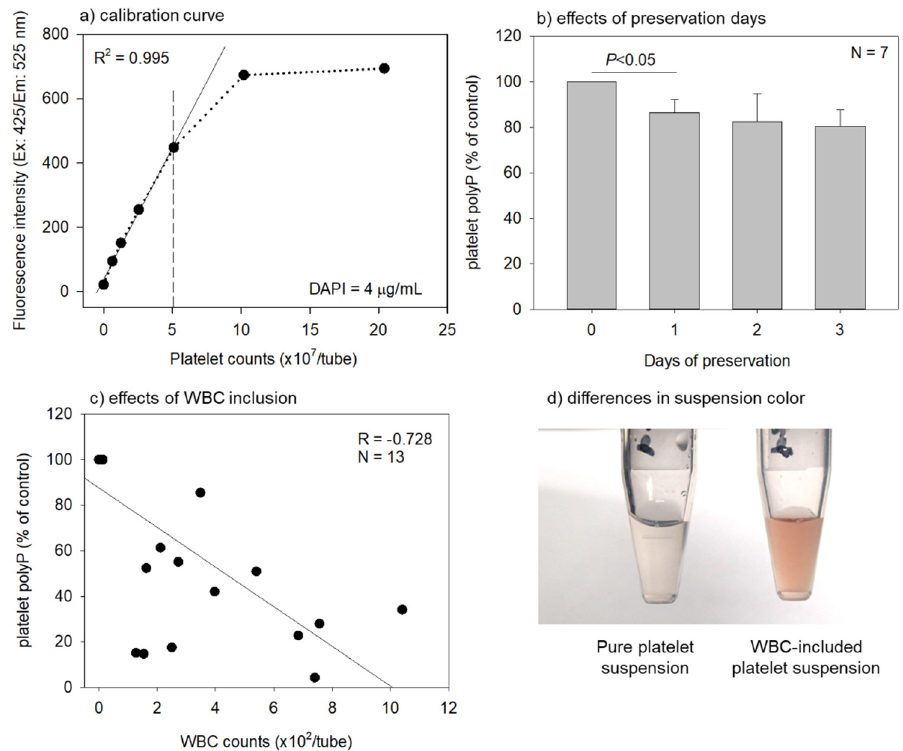
Figure 3. Standard curve for DAPI-reactive fluorescence intensity against platelets and the effects of various factors on polyP quantification. ( a ) A standard curve for the fluorescence signals in platelets probed with 4 μ g/mL DAPI. A good linear regression (R 2 = 0.995) was obtained in the range of platelet counts (up to 5 × 10 7 /tube). ( b ) The effects of preservation days on quantification of platelet polyP levels ( n = 7). A significant difference was observed only in the first 1-day interval. ( c ) Effects of WBC inclusion on quantification of platelet polyP levels. Since WBCs may shift the original polyP quantification upward, this downward shift may be due to RBC inclusion; a strong correlation (R = − 0.728) was observed; n = 13. ( d ) The representative difference in suspension color. The suspension including WBC was faintly stained red (right).